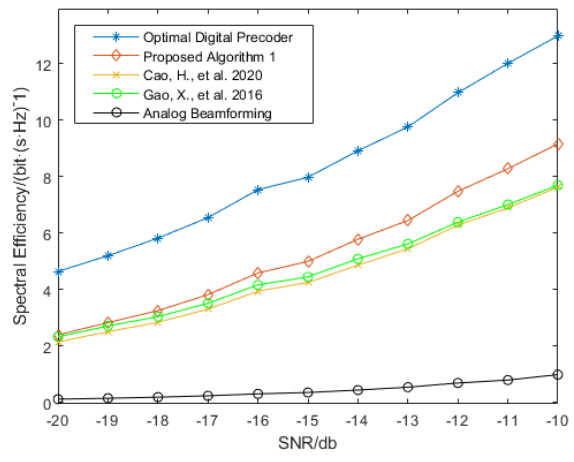
Figure 2. At low SNR, spectral efficiency of different algorithms ( N t × N r = 128 × 16, N RF = 8, N s = 8) [18,21].